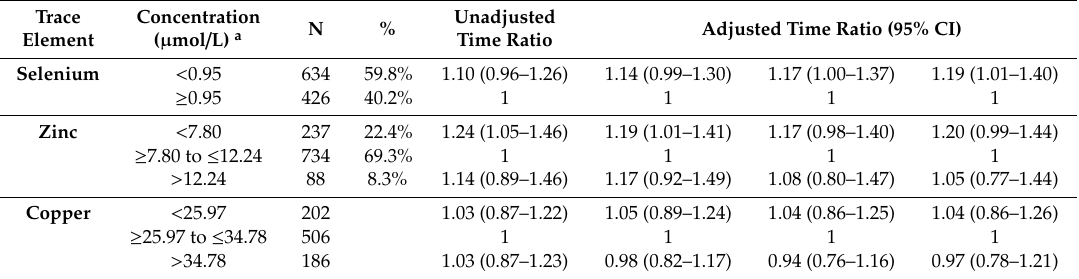
Table 2. Association between plasma trace element concentration measured at 15 ± 1 weeks’ gestation and time to pregnancy.